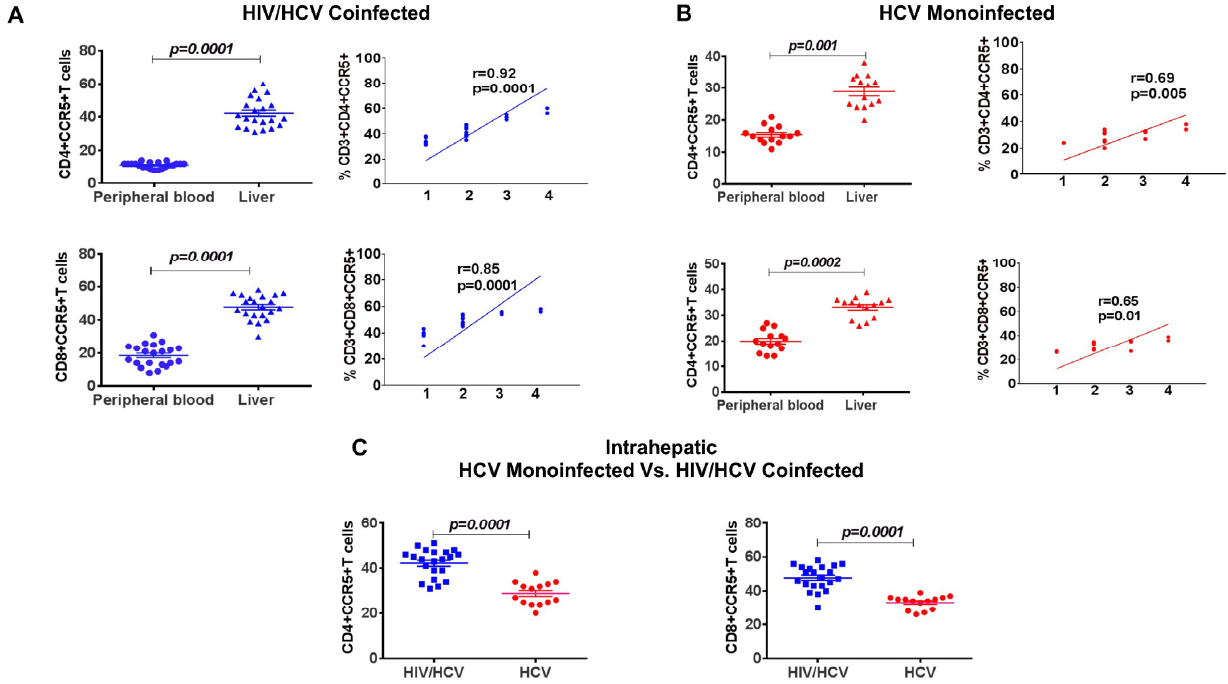
Figure 4. Peripheral blood vs. liver analysis in HIV/HCV coinfection and HCV monoinfection. Dot plot graphs showing the differences in the frequencies of CCR5 on CD4+ and CD8+ T cells in the peripheral and intrahepatic compartment and XY scatter plots showing the correlation (Pearson correlation analysis) between CCR5 frequencies in the liver and fibrosis stage in ( A ) HIV/HCV-coinfected patients (n = 21) and ( B ) HCV monoinfected (n = 14) patients who underwent paired liver and peripheral blood sampling. ( C ) The intrahepatic differences in the frequencies of CCR5 on CD4+ and CD8+ T cells in the 14 monoinfected and 21 HIV/HCV-coinfected patients.